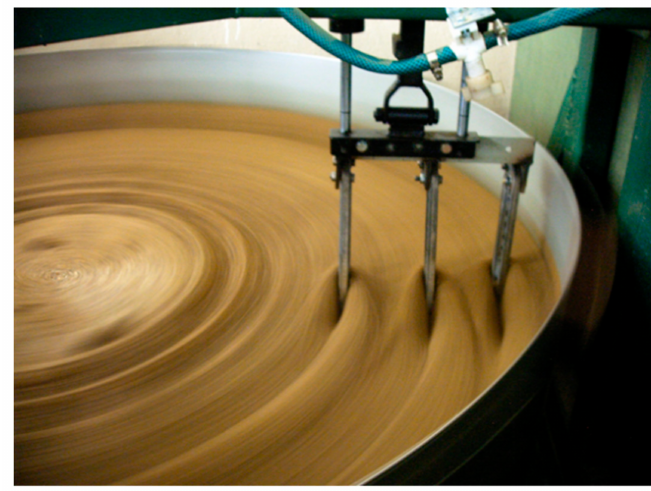
Figure 4. Samples during the tribological test.